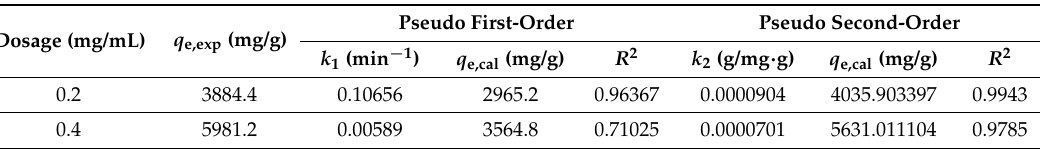
Table 2. Kinetic parameters for GO coagulation onto